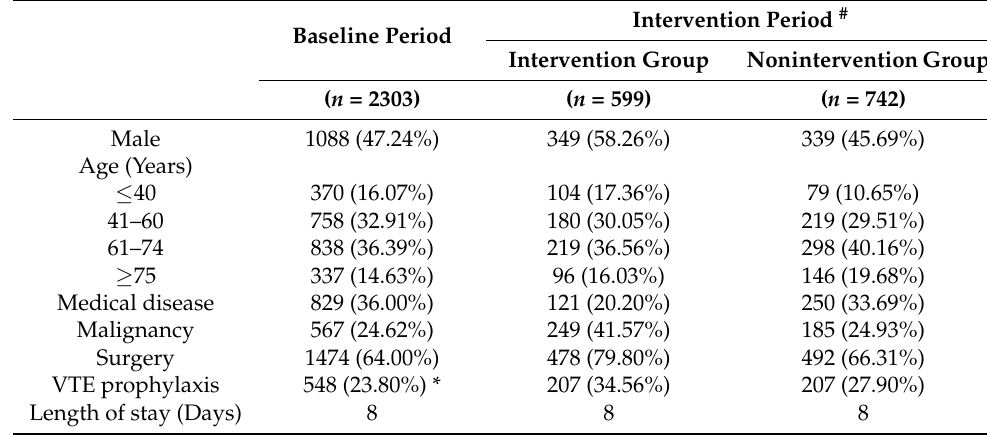
Figure 2. Recruitment process and flow through study. LOS: length of stay; AMI: acute myocardial infarction; AF: atrial fibrillation; AS: acute stroke; ECMO: extracorporeal membrane oxygenation. Table 1. Characteristics of patients in baseline and intervention